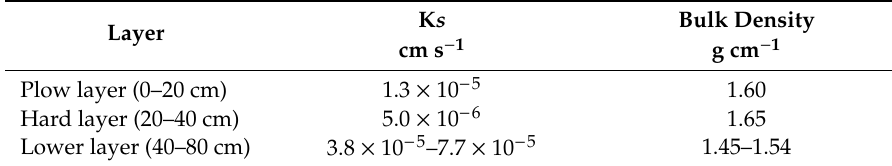
Table 1. Physical properties of soil in the experimental field.